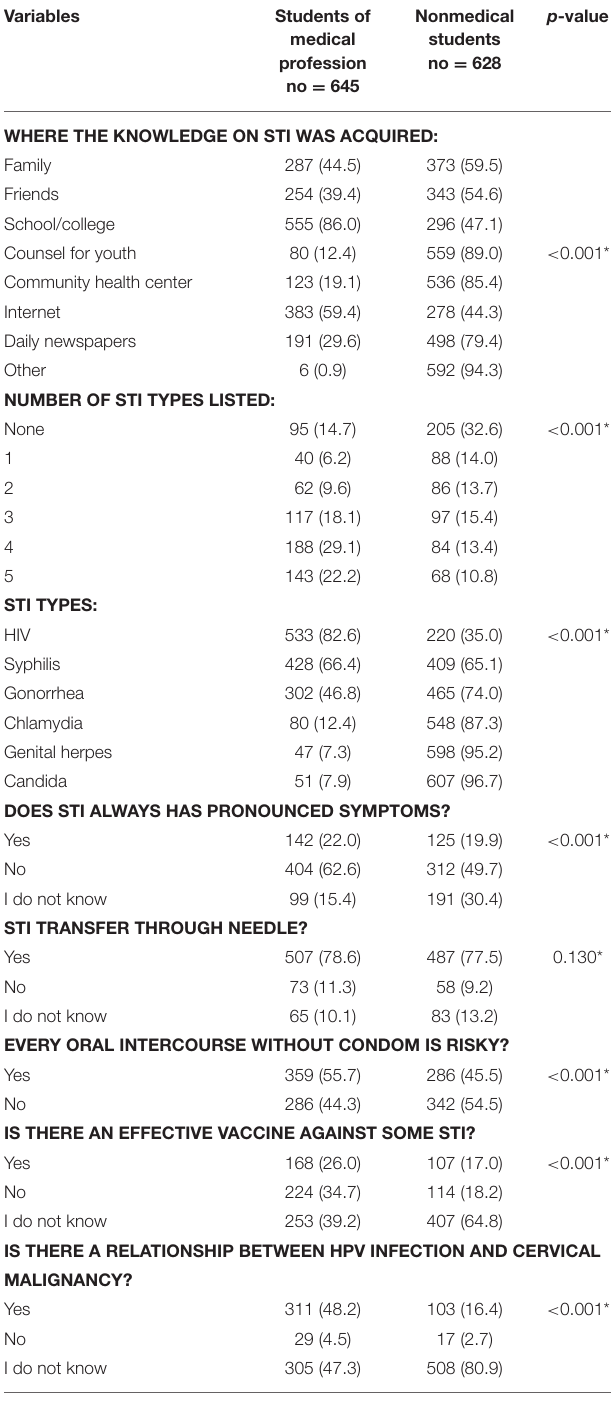
TABLE 2 | Student’s knowledge about